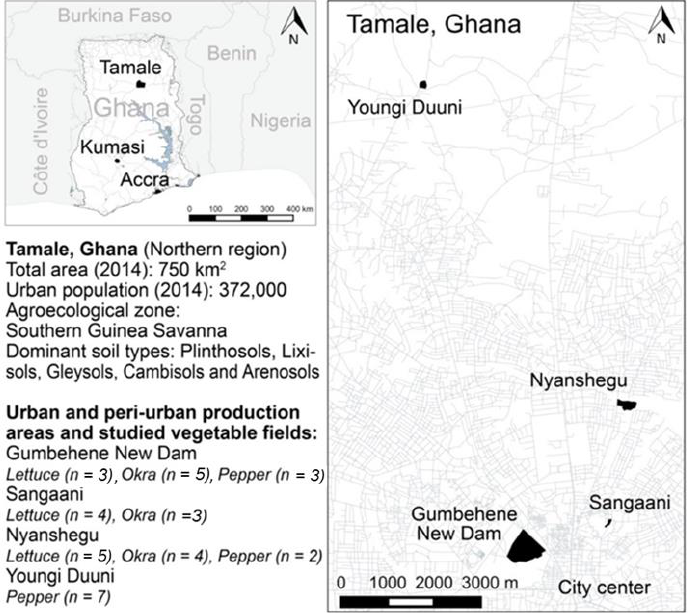
Figure 1. Map of Ghana with major cities ( left ) and Tamale in the Northern Region of Ghana ( right ) showing the location of the studied urban and peri-urban production systems. Data retrieved from